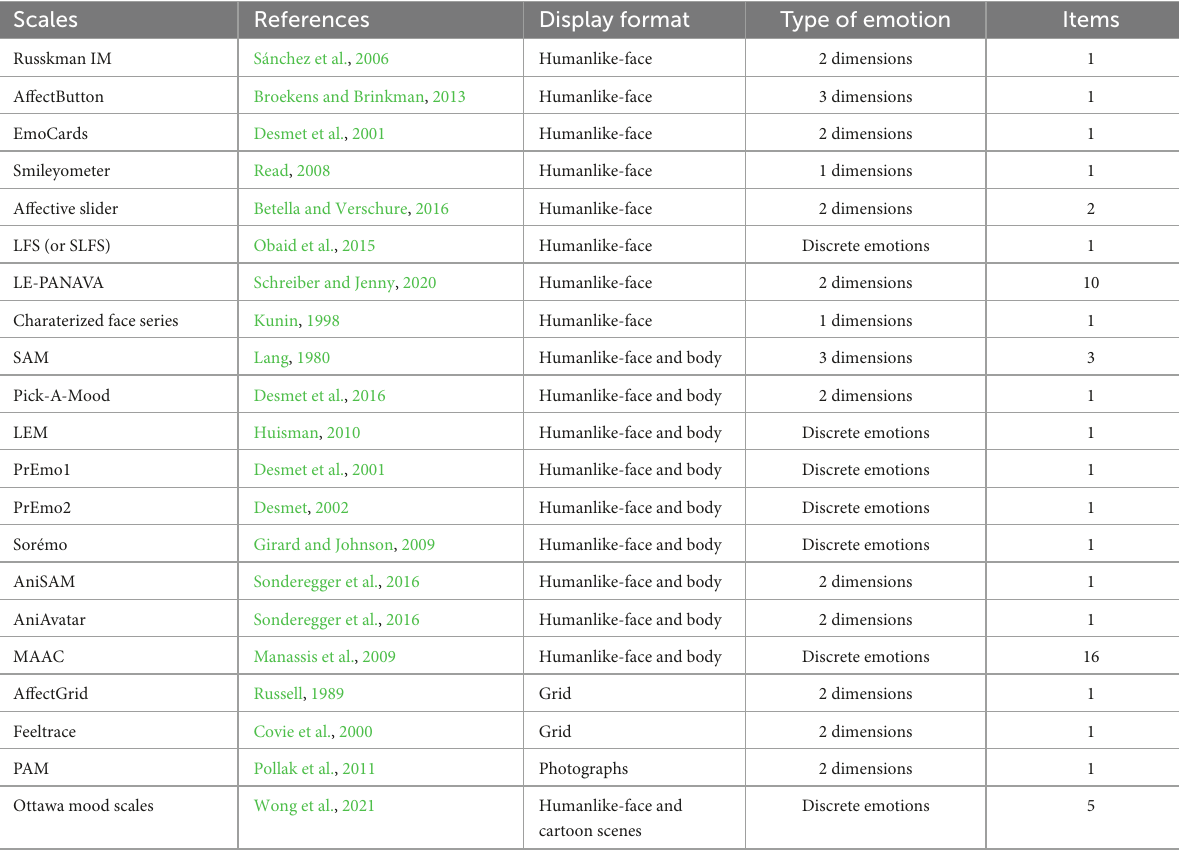
TABLE 2 Picture-based scales for emotional measures. Scales